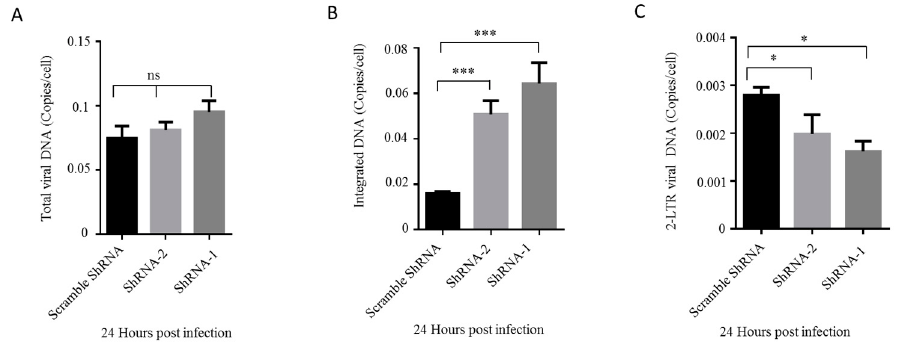
Figure 3. HDAC10 downregulation enhances viral integration. HDAC10 shRNA transduced or scramble shRNA transduced Jurkat cells were infected with HIV-1 (N119). 24 h later, cells were collected and total viral DNA ( A ), viral integrated DNA ( B ), and 2-LTR DNA ( C ) were analyzed by quantitative PCR. Data are mean and sd. Ns, no significance; *, p < 0.05; ***, p < 0.005. (Two-tailed unpaired t -test).